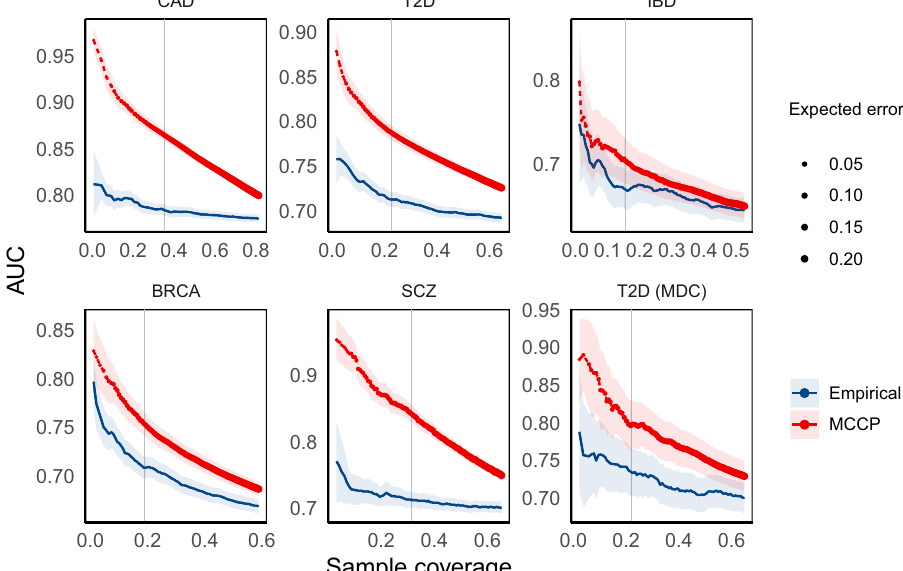
Fig. 4 Comparison of the performance of MCCP and the empirical method on complex disease risk prediction using PRS and additional information (age, sex, and PC1 – 6) in MCCP. For MCCP, sample coverage ( x axis) indicates the proportion of samples predicted as cases or controls, whereas, for the empirical method, it indicates extreme PRS, e.g., top and bottom x% of PRS. AUCs are computed from multivariate logistic regressions adjusted for age, sex, and PC1 – 6 on these samples strati fi ed from MCCP and empirical method, respectively. The expected error rates for MCCP are indicated by the size of data points up to 0.20. Vertical lines correspond to an expected error of 0.05 from the MCCP. The solid lines and shades represent the median and 95% con fi dence intervals of AUCs. CAD coronary artery disease, T2D type 2 diabetes mellitus, IBD in fl ammatory bowel disease, BRCA breast cancer, SCZ schizophrenia, T2D (MDC) T2D data set from the MDC study at the baseline. Source data are provided as a Source Data fi